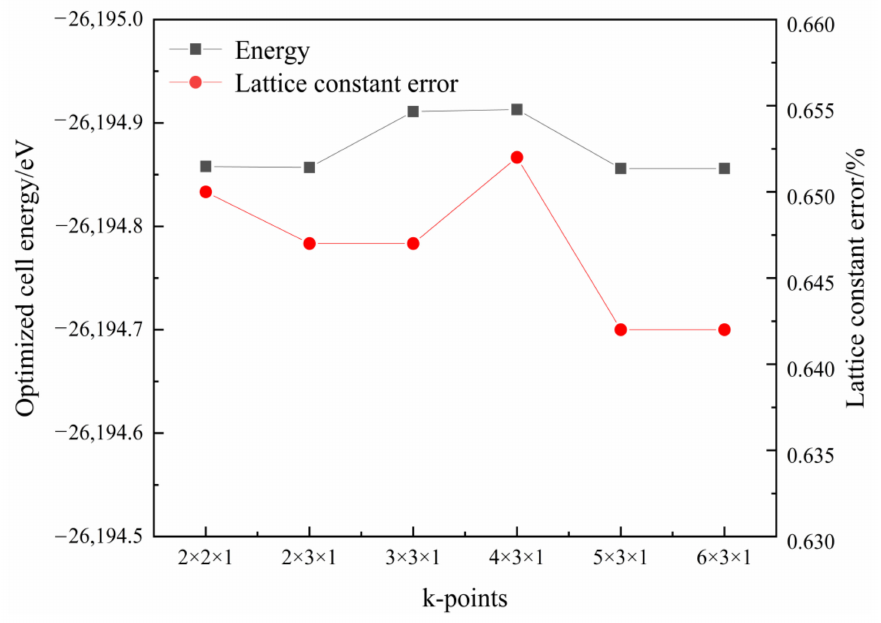
Figure 5. Total energy and lattice constant errors of muscovite at different